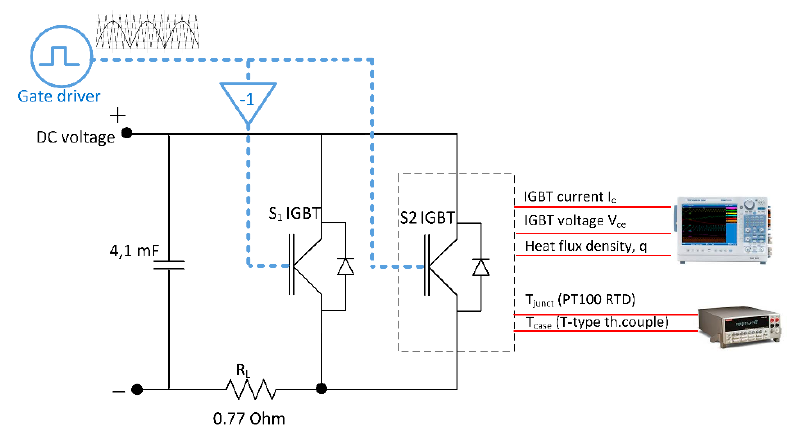
Figure 7. Test setup for the IGBT heat flux measurements.